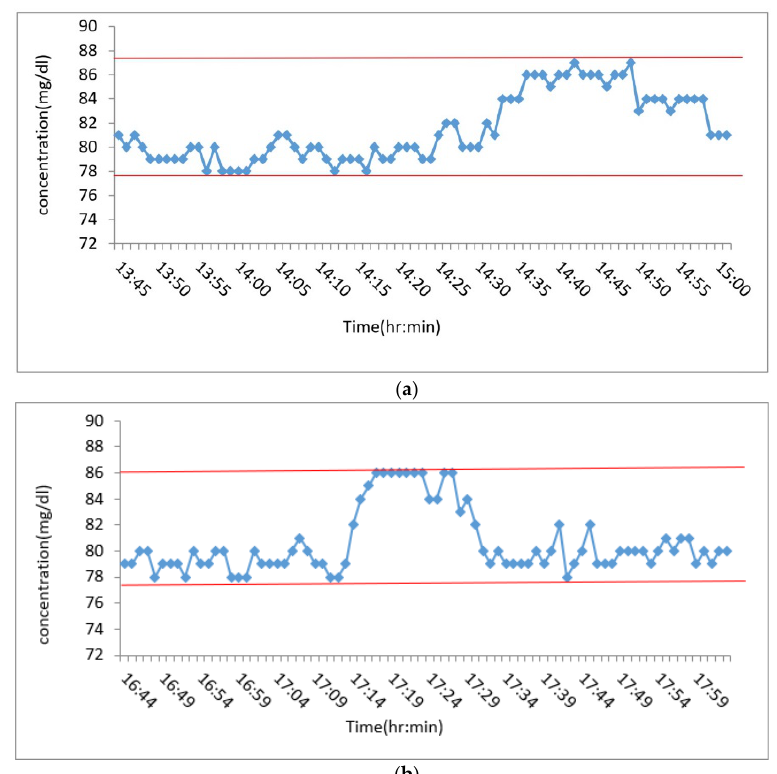
Figure 15. ( a ) Continuous blood glucose signal of subject-1; ( b ) continuous blood glucose signal of subject-2.